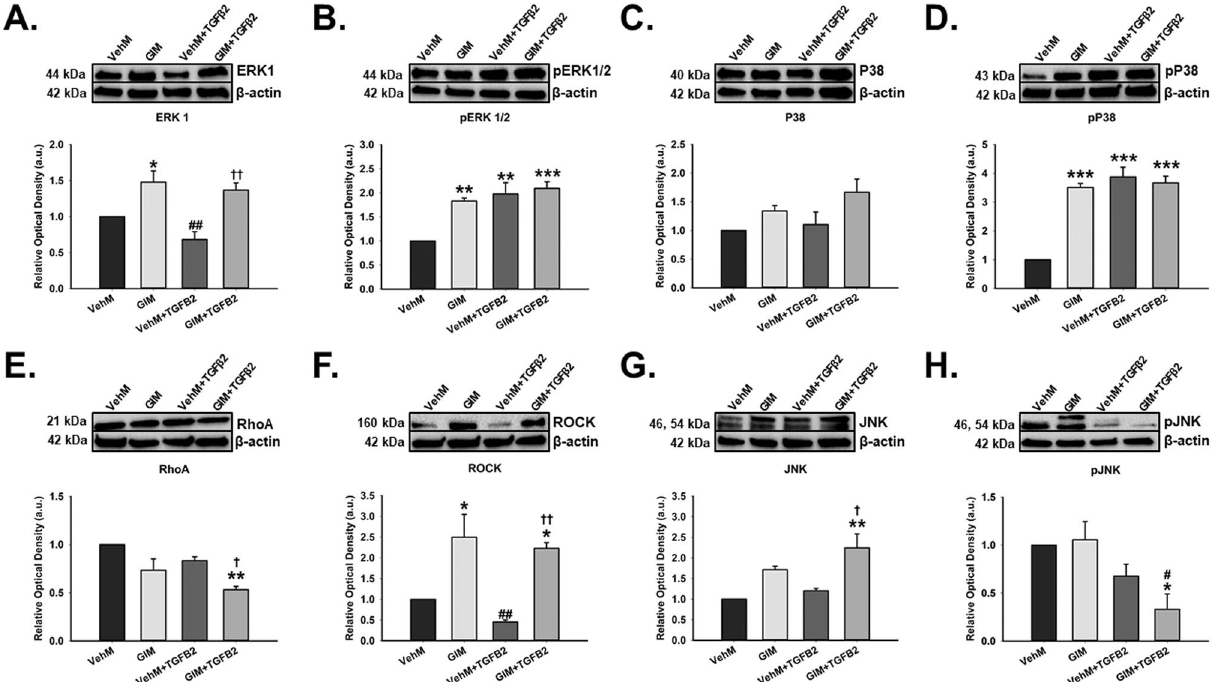
Figure 2. GIMs potentiate non-Smad-dependent TGFβ signaling with or without exogenous TGFβ2 in hTM cells. Primary hTM cells were cultured in the presence or absence of 100 nM dexamethasone for 4 weeks in complete growth media. Cells were subsequently removed using 20 mM ammonium hydroxide solution to obtain GIMs and vehicle control matrices (VehMs). Same strain, fresh primary hTM cells were then seeded on these matrices with or without exogenous 5 ng/mL TGFβ2 in 1% fetal bovine serum growth media for 24 hours. Protein was extracted for Western blot analysis. β-Actin was used as an internal control for normalization. Representative cropped blots (top) and densitometric analysis (bottom) of (A) Extracellular signal regulated kinase 1 (ERK1), (B) Phosphorylated ERK1/2 (pERK1), (C) P38, (D) Phosphorylated P38 (pP38), (E) RhoA, (F) Rho-associated protein kinase 1 (ROCK1), (G) c-Jun N-terminal kinases (JNK), and (H) Phosphorylated JNK (pJNK). Columns and error bars ; means and standard error of mean (SEM). One-way ANOVA with the Tukey pairwise comparisons post hoc test was used for statistical analysis. (n = 4 biological replicates. *p < 0.05, **p < 0.01, ***p < 0.001 for the group of interest versus control, VehM. # p < 0.05, ## p < 0.01 for the group of interest versus GIM. † p < 0.05, †† p < 0.01 for VehM + TGFβ2 versus GIM + TGFβ2). hTM, human trabecular meshwork. Black horizontal demarcating lines between the blots indicate two images taken from two different parts of the same membrane blot. Full length blots can be found in Supplementary Figs. S7A–H and S8A–H, respectively. Densitometric analyses was done using ImageJ 1.8.0_112 software (https ://image j.nih.gov/ij/,